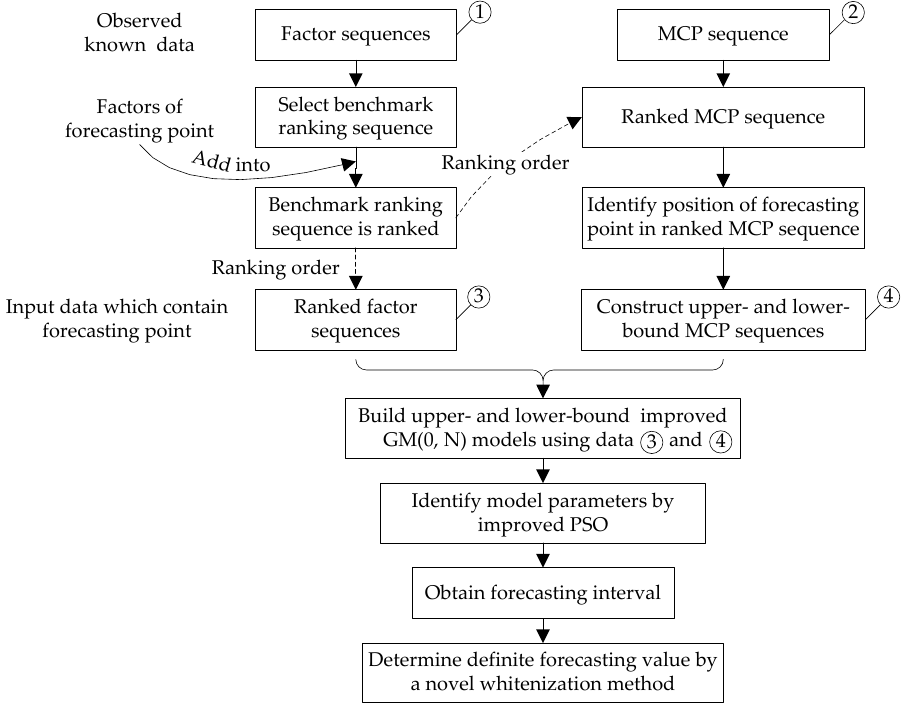
Figure 2. Flow chart of the calculation process of the proposed interval GM(0, N) model.